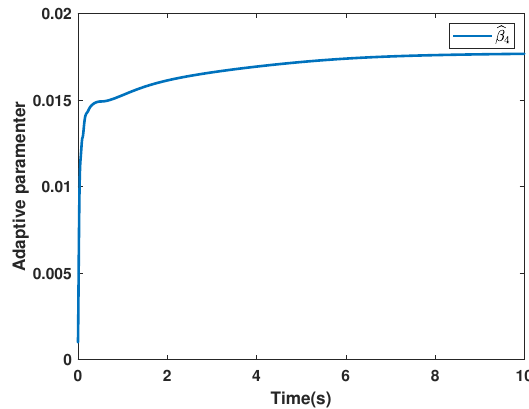
Figure 12. Adaptive parameter (cid:98) β 4 ( t )